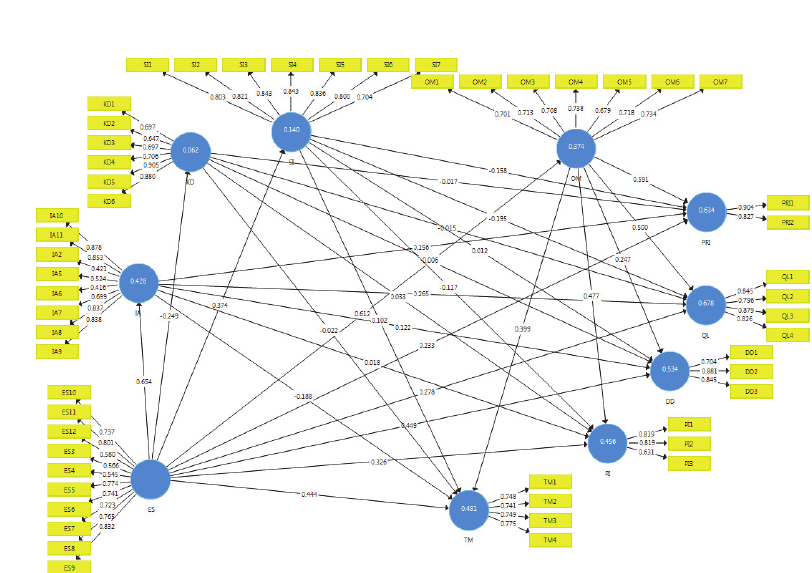
Fig. 2. Measurement Model Assessment (Reflective 1 st